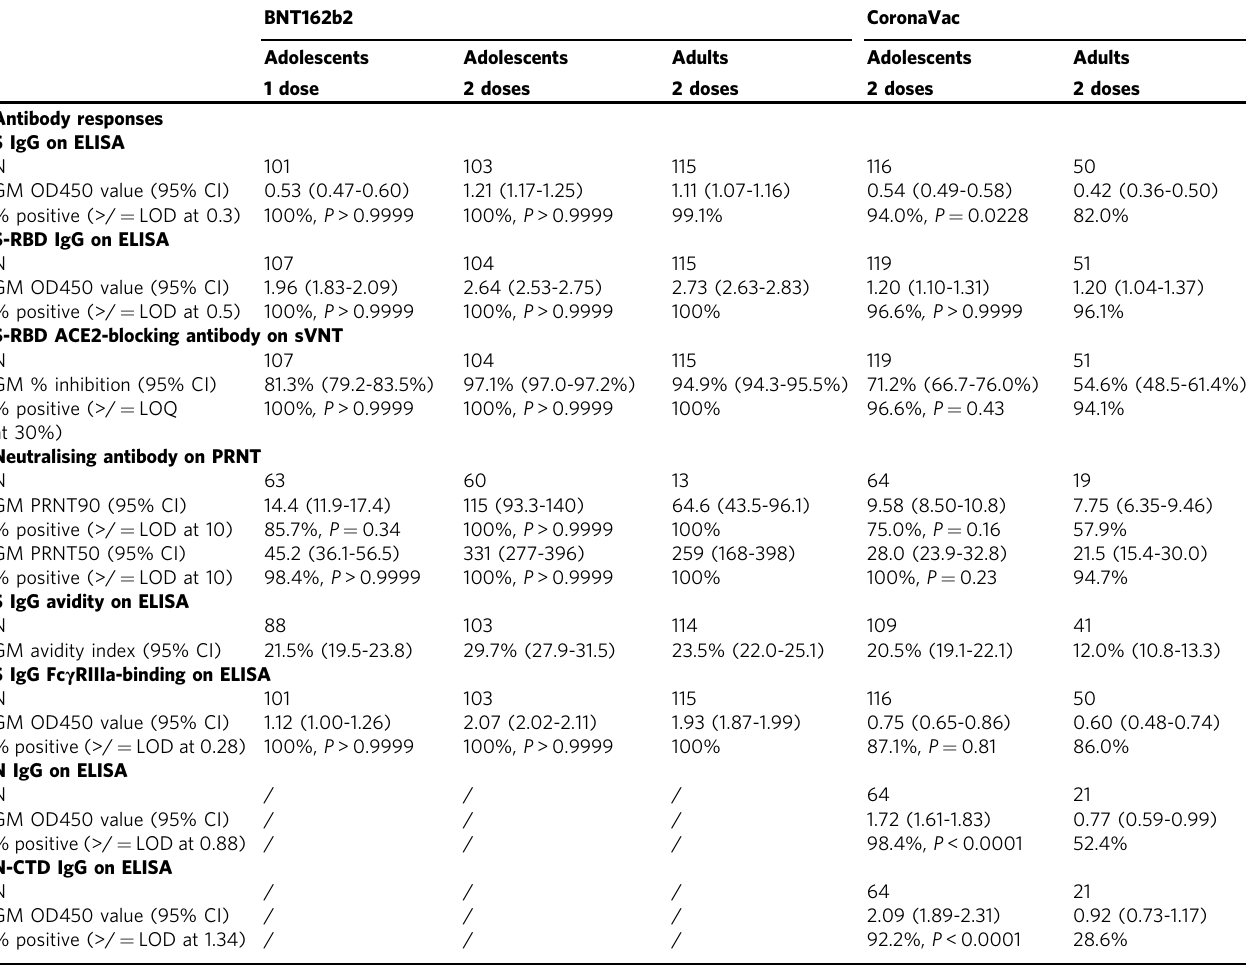
Table 1 Humoral immunogenicity outcomes in evaluable analysis populations by vaccine